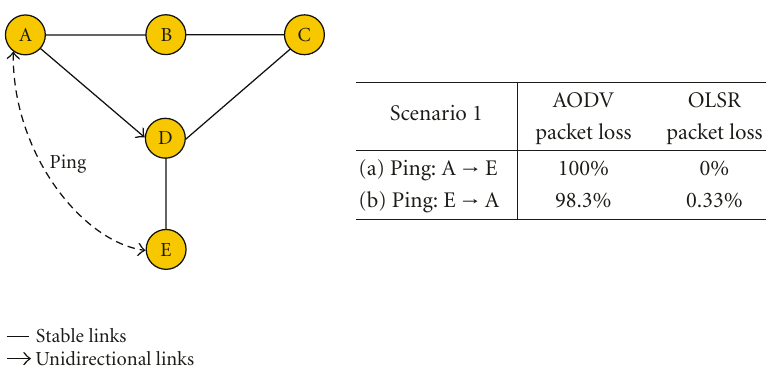
Figure 8: Unidirectional links: scenario 1 (network topology and experimental